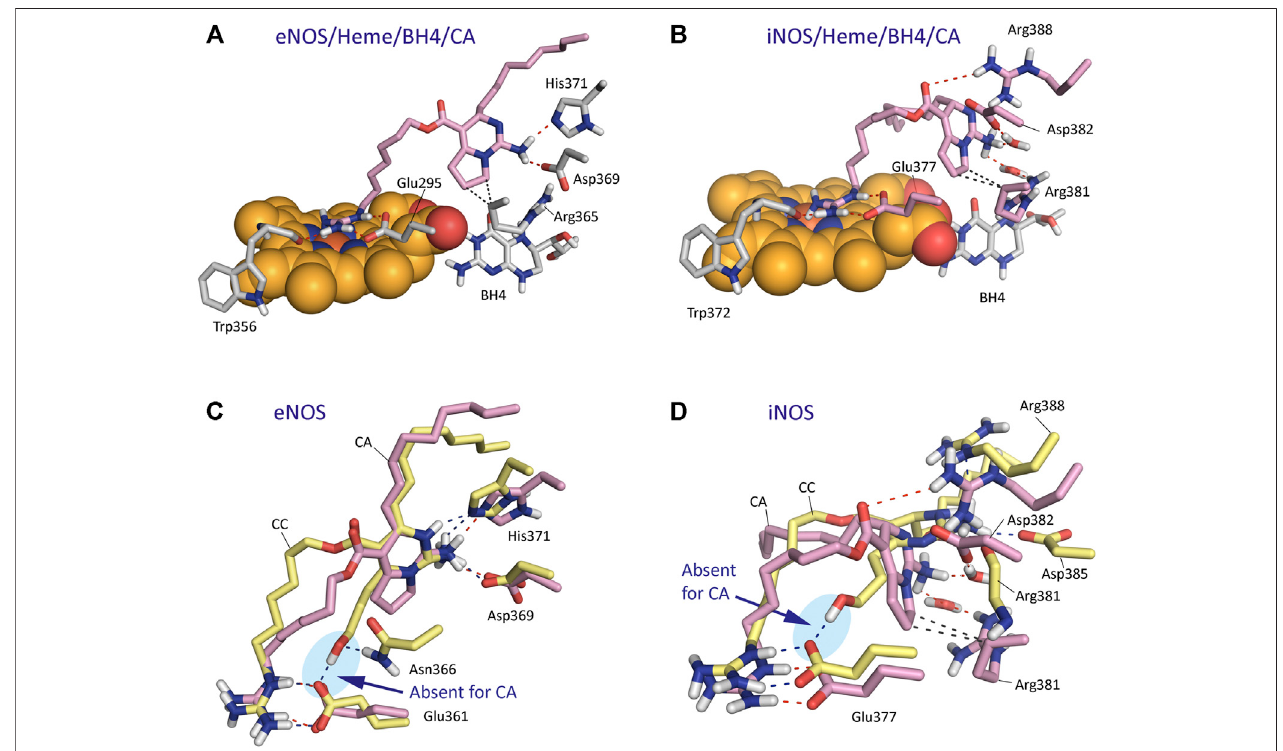
FIGURE 8 | Binding mode of Crambrescin A1 (CA, pink) in the active site of NOS enzymes obtained by docking and MD simulation studies. (A) Overall view of the eNOS/Heme/BH4/CA enzyme complex. Snapshot after 140 ns of simulation is shown. (B) Overall view of the iNOS/Heme/BH4/CA enzyme complex. Snapshot after 80 ns of simulation is shown. (C,D) Comparison of the binding modes of CA (pink) and CC (yellow) with eNOS (C) and iNOS (D) enzymes. Relevant side chain residues are shown and labeled. The position of the heme group (spheres) and BH4 are shown (A,B). Polar (red, blue) and apolar (black) interactions between ligands and NOS enzymes are shown as dashed lines. Note how only CC would have an strong hydrogen bonding interaction with Glu361/Glu377 residues (blue shadow).